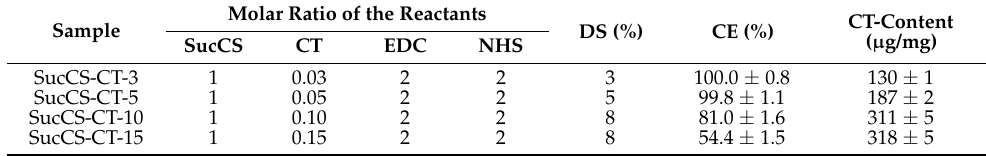
Table 1. Condition for synthesis and characterization of succinyl chitosan-colistin conjugate (SucCS-CT). Sample